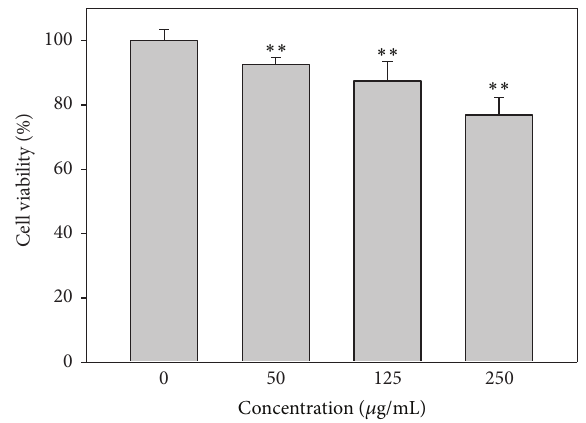
Figure 1: Cell viability of IS-treated HUVECs. Cells were treated with 0, 50, 125, and 250 𝜇 g/mL of IS for 48h and subjected to crystal violet assay. Data, mean ± SD ( 𝑛 = 12 ). ∗∗ 𝑃 < 0.0001 .